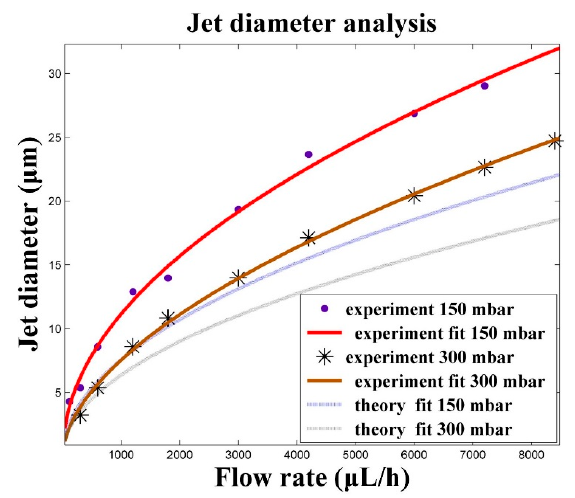
Figure 5. Comparison of experimental data with theoretical predictions for jet diameter and breakup transition analyses.